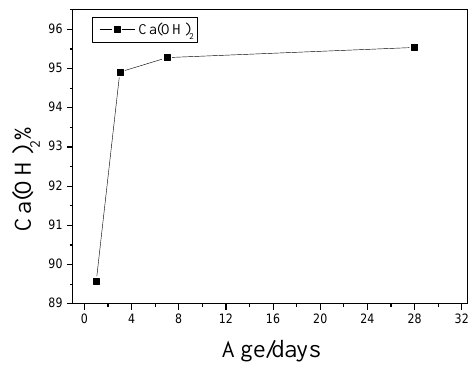
Figure 5. The mass loss of Ca(OH) 2 at different ages.